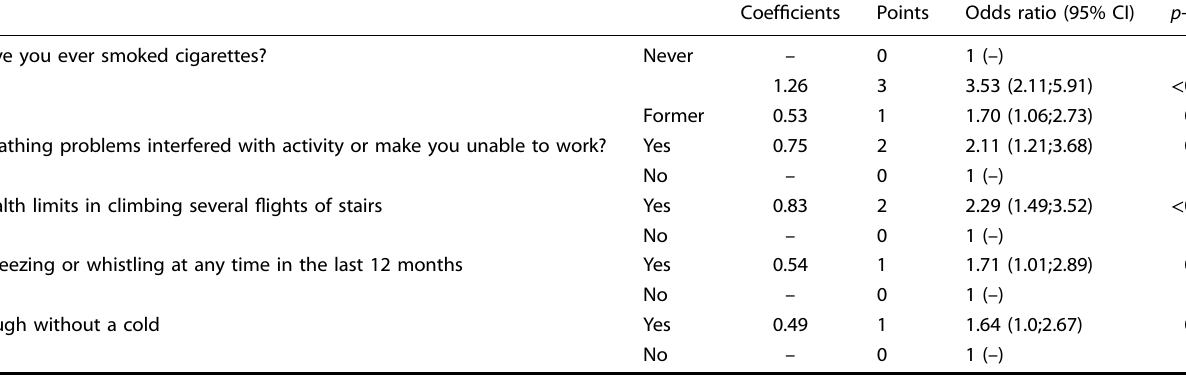
Table 2. Multivariate predictors of PBD FEV1/FVC < LLN1- results from the population-based training subsample ( n = 800)